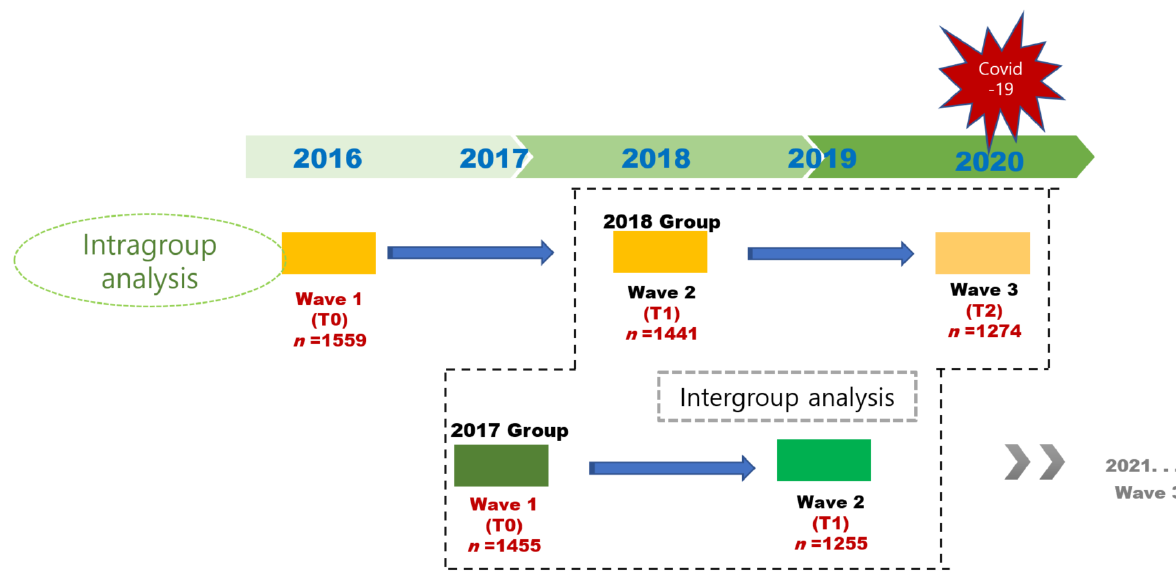
Figure 1. KFACS cohort scheme and intergroup analysis, intragroup analysis.